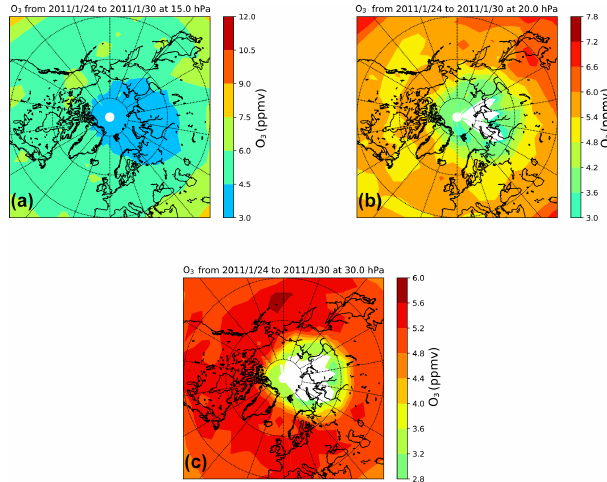
Figure 13. Distribution of the average ozone VMR at 15 (a) , 20 (b) , and 30hPa (c) over the northern polar region in the time period of 24 to 30 January during the winter 2011 ozone depletion. The white area shows a lack of measurements caused by the presence of polar stratospheric